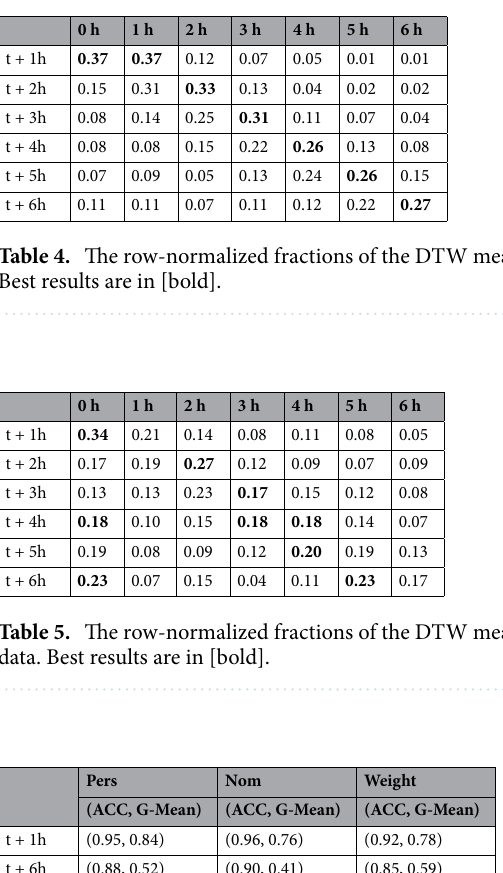
Pers Nom Weight (ACC, G-Mean) (ACC, G-Mean) (ACC, G-Mean) t + 1h (0.95, 0.84) (0.96, 0.76) (0.92, 0.78) t + 6h (0.88, 0.52) (0.90, 0.41) (0.85,